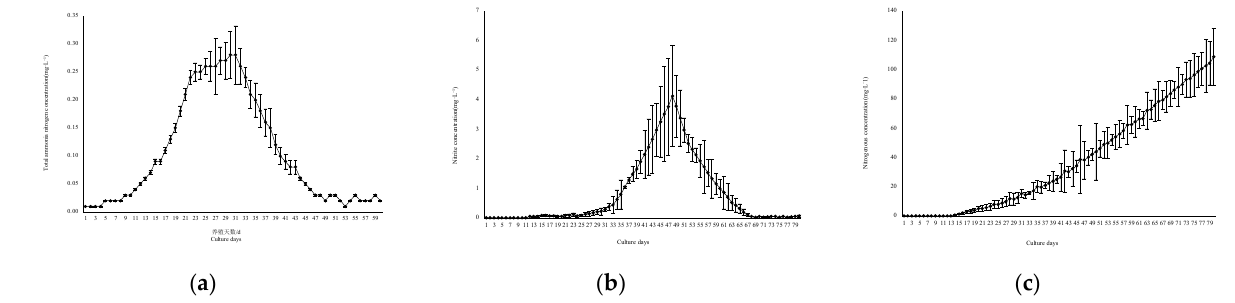
Figure 3. Variation curve of ammonia nitrogen, nitrite nitrogen, and nitrate nitrogen concentration. ( a ) Total ammonia nitrogen; ( b ) Nitrite; ( c ) Nitrogenous.